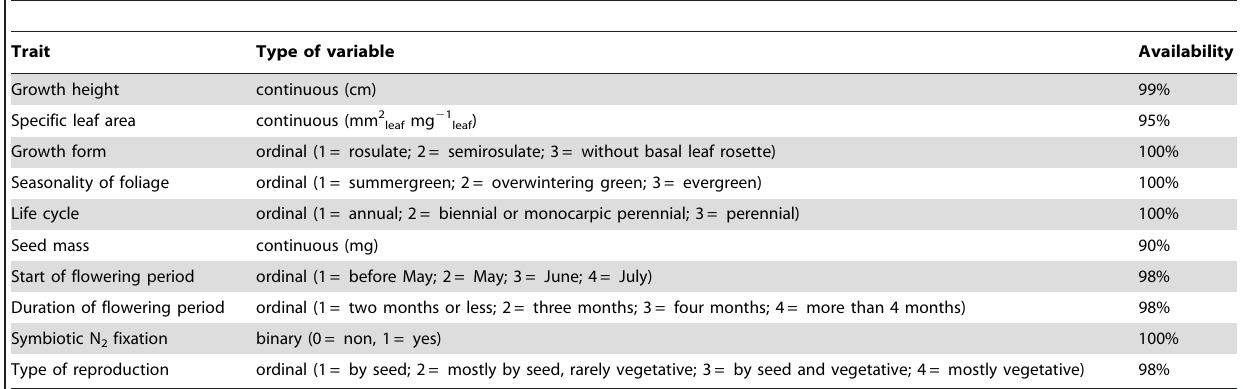
Table 1. Overview of plant traits used in analyses of functional trait diversity and community-weighted mean traits.